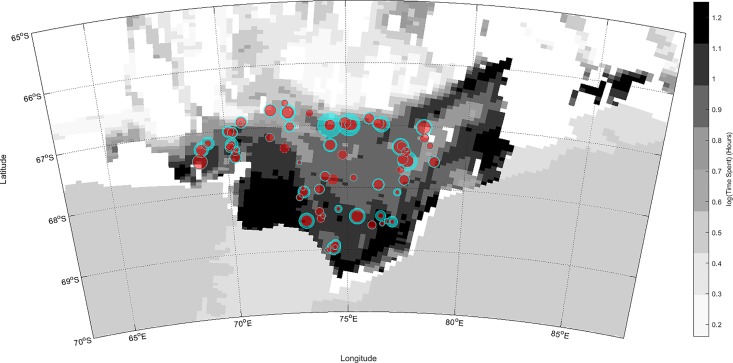
Historical pelagic and benthic fish data distribution, showing species richness (red) and proxy fish biomass (cyan).The size of the circle indicates the relative value of both indicators. Species richness is the total number of species, and the proxy biomass was obtained from the total summed fish length (mm) for pelagic and benthic species standardized by trawl effort (Speed [kn] x Tow Duration [min]/60, see Methods). Background shows predicted habitat selection for PM1.